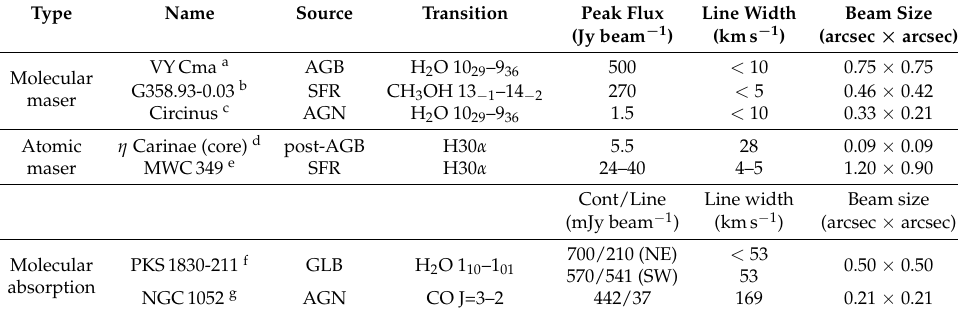
Table 2. Different types of spectral line sources at sub-mm